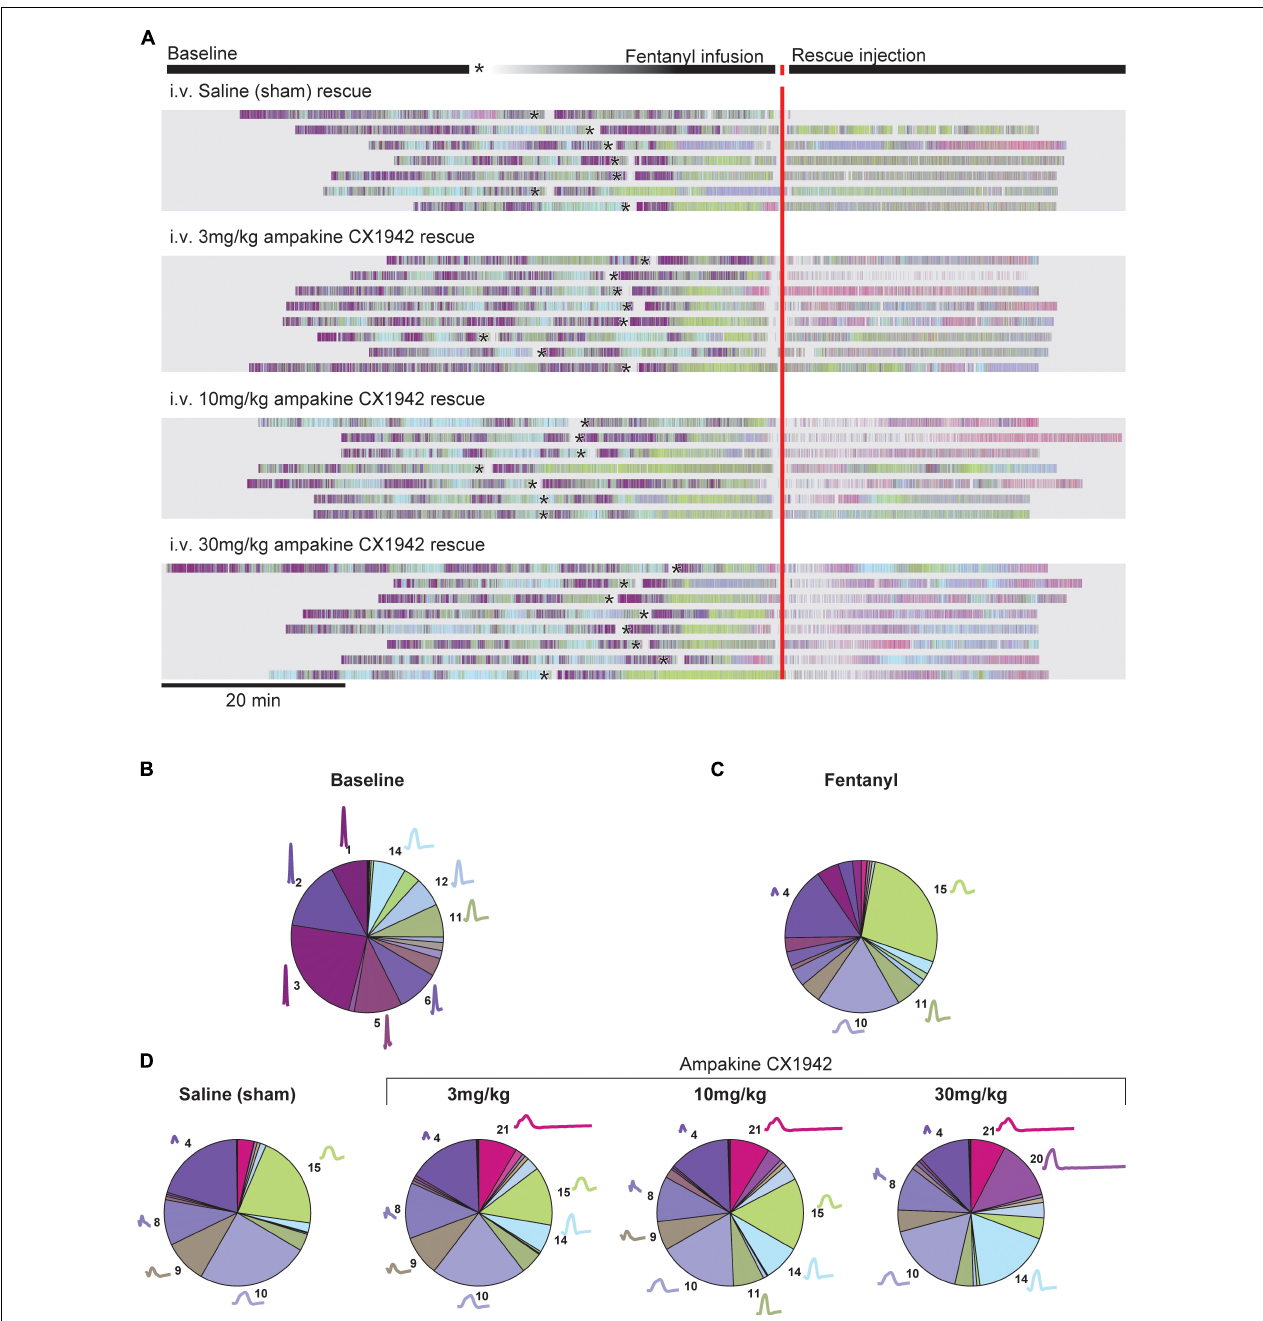
FIGURE 5 | Cluster prevalence throughout experimental protocol stratified by rescue condition. (A) Peri-event raster plot, aligned to the rescue injection. Each line in the raster plot represents a single animal in each experimental condition. Rasters mark the beginning of inspiration for each breath; raster colors match cluster colors from Figure 1 . The beginning of the fentanyl infusion is marked with an asterisk (*). Two animals excluded from plot due to prolonged fentanyl infusion period. The proportion of each cluster during the (B) baseline ( n = 32, all animals in study pooled together), (C) fentanyl ( n = 32, all animals in study pooled together), (D) rescue periods ( n = 8 animals/treatment group). The average waveform and cluster number is plotted next to the pie segment if the cluster prevalence was greater than